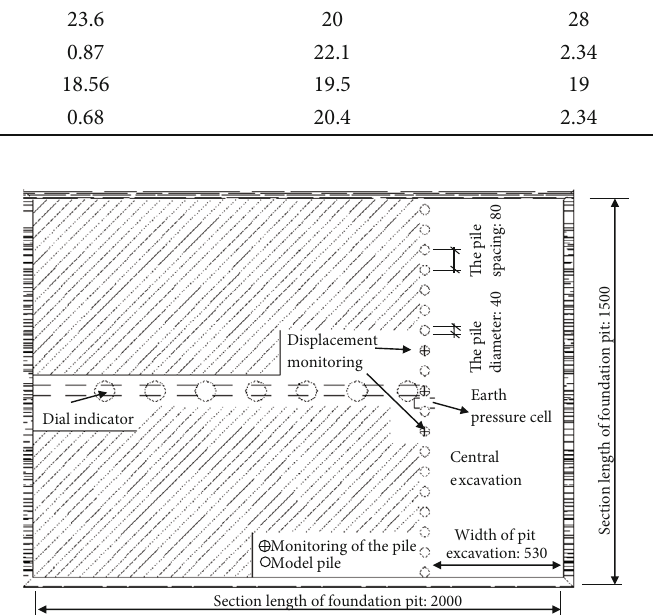
Figure 5: Overview of the physical model